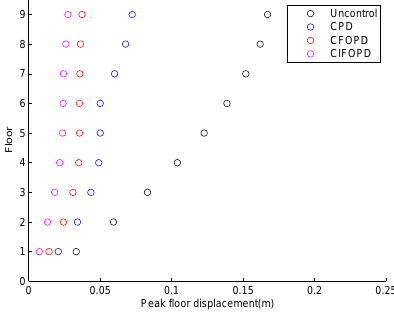
Figure 6. Maximum displacement of each floor under centralized control.